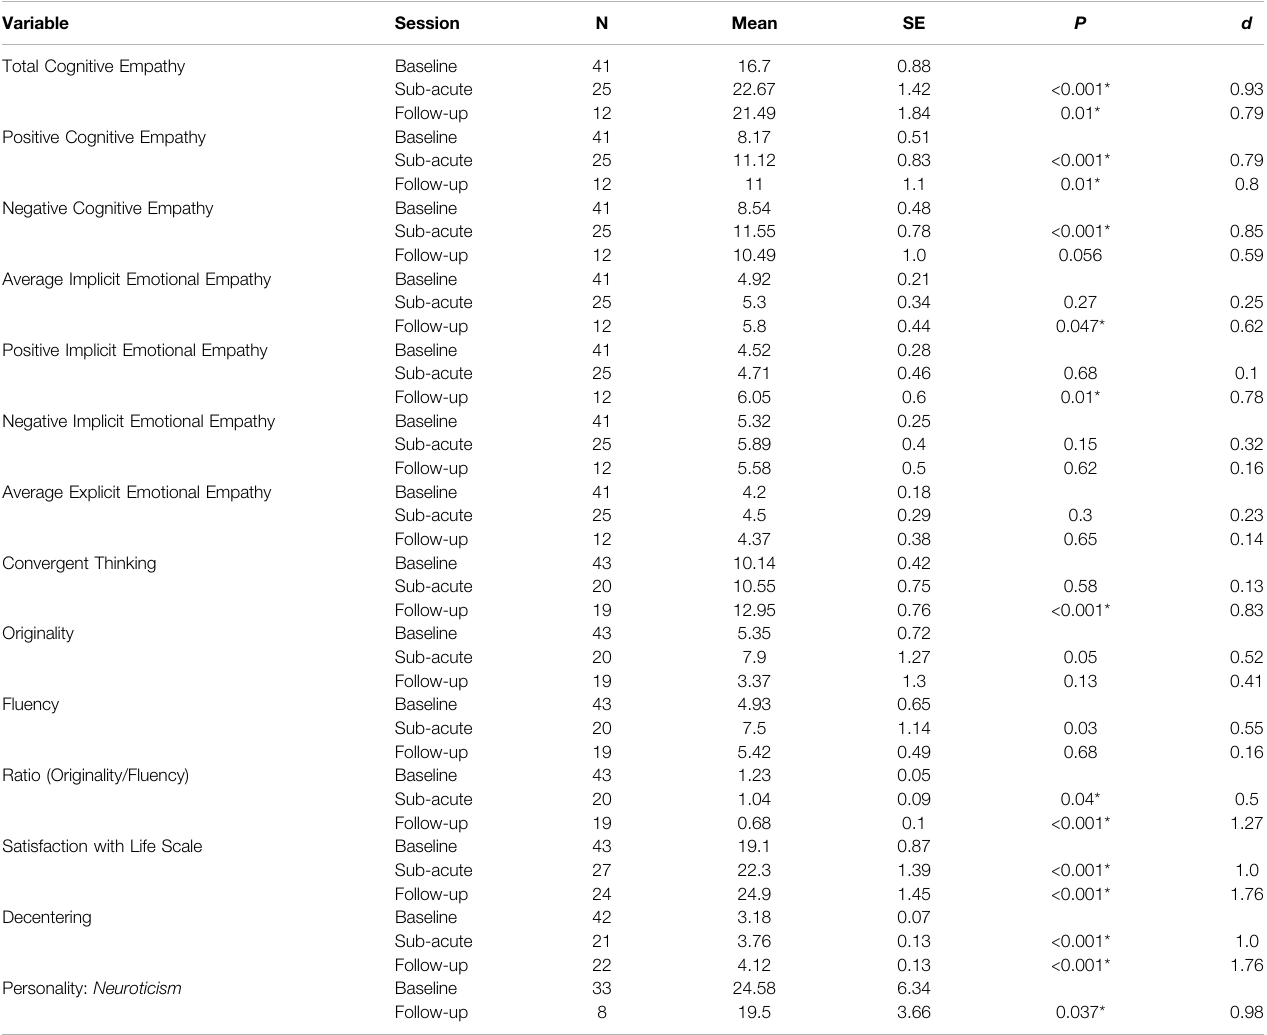
TABLE 2 | Summary of contrast analyses of the dependent measures.